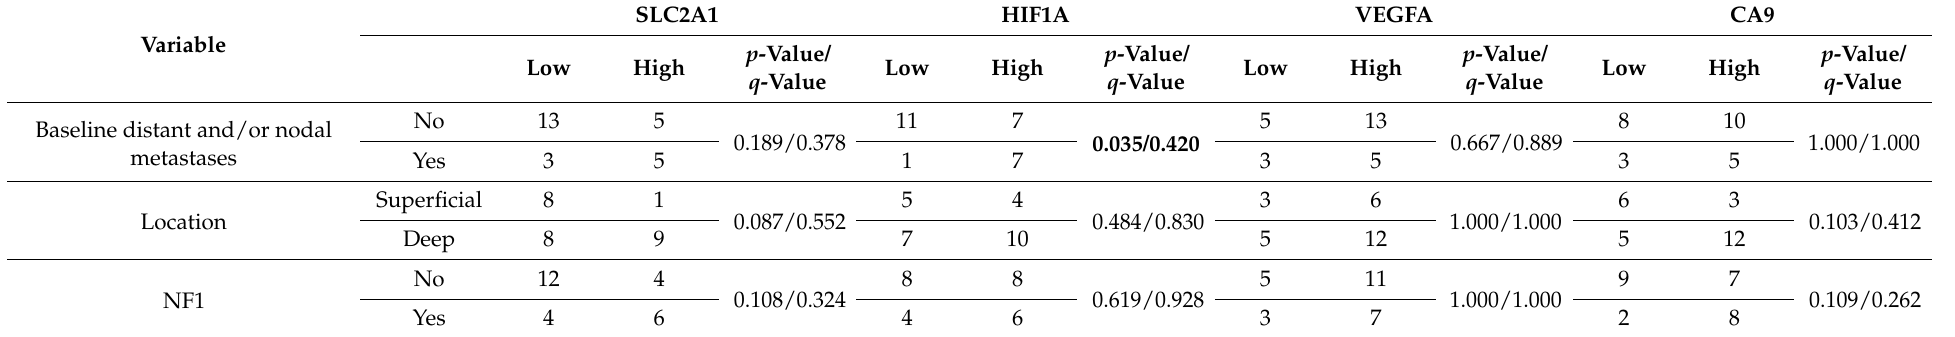
Table 3. Pair-wise correlations between markers of hypoxia. Significant p -values after Benjamini–Hochberg correction are written in bold letters. SLC2A1 HIF1A VEGFA p -Value/ Low High Low High q -Value Low 9 3 0.191/0.573 HIF1A Low 6 2 0.419/0.628 VEGFA Low 10 CA9